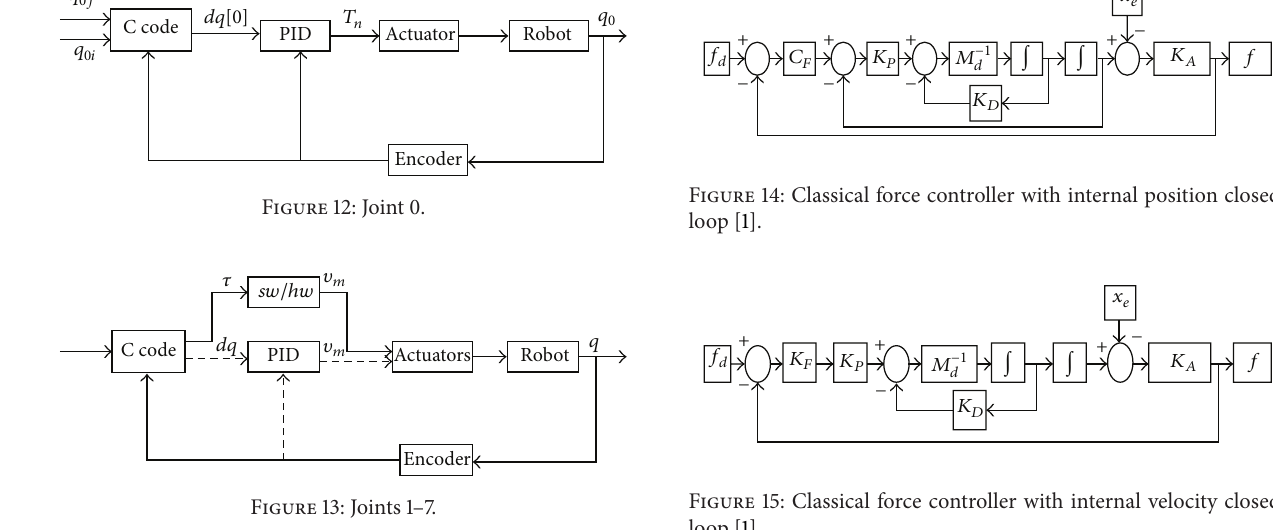
Figure 15: Classical force controller with internal velocity closed- loop